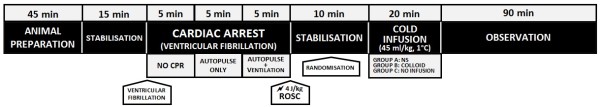
Flow chart of the animal experimental protocol. CPR, cardiopulmonary resuscitation; ROSC, return of spontaneous circulation; NS, normal saline.